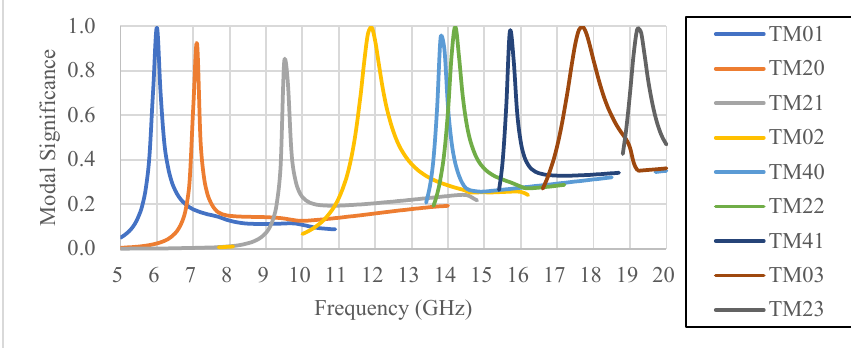
Figure 6. Modal significance of the proposed patch antenna without slot.